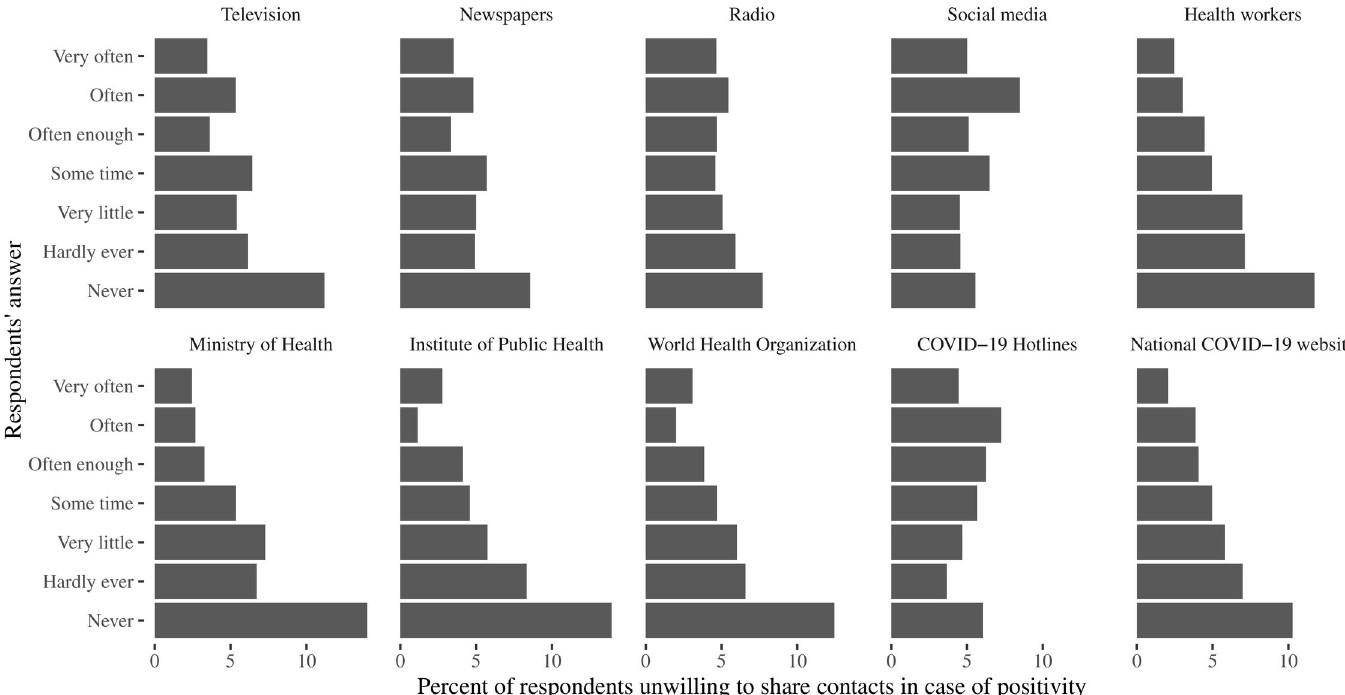
Fig 3. Percent of respondents who expressed unwillingness to share contacts in case of positivity, according to their response to the questions “How often you use COVID-19 related information from the following sources”. The sources of information are named at each panel on the figure.